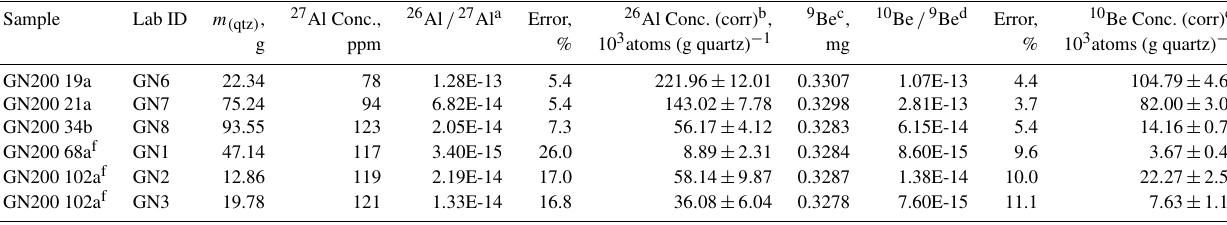
Table 2. Analytical information for burial age calculations. Sample Lab ID m ( qtz )